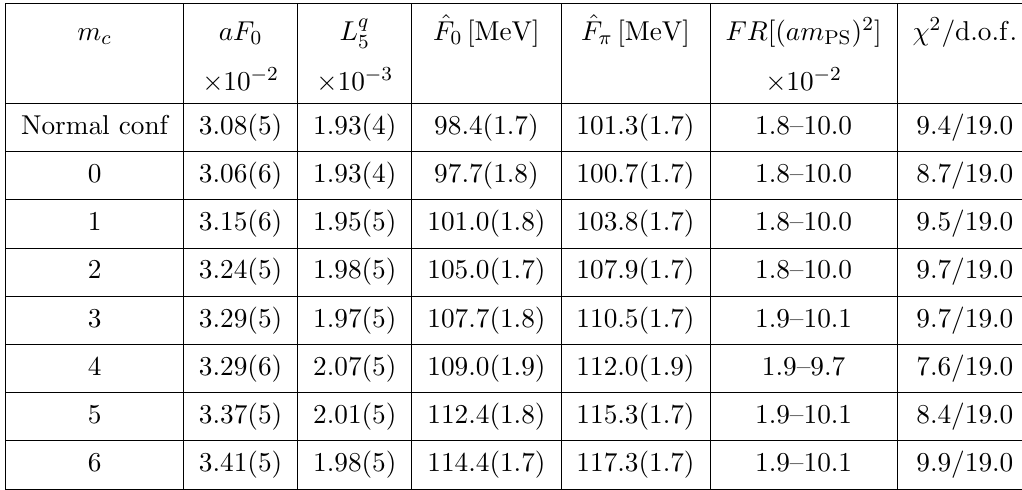
. The computed results of the renormalized decay 5